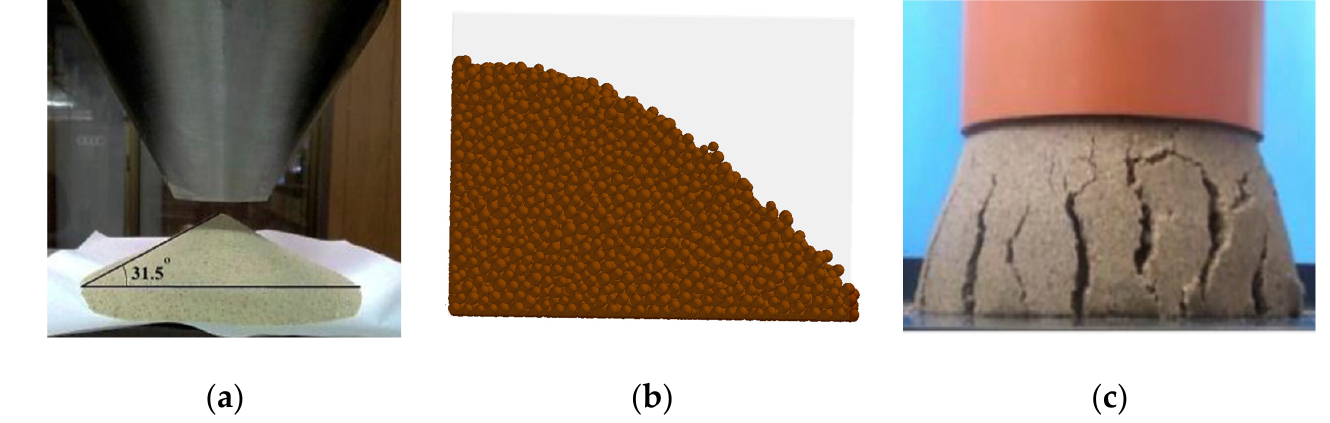
Figure 8. Angle of repose test setup used by ( a ) Ucgul et al. [29] for a cohesionless soil, ( b ) Mousaviraad et al. [83] for maize, and ( c ) Roessler and Katterfeld [96] for a cohesive soil.